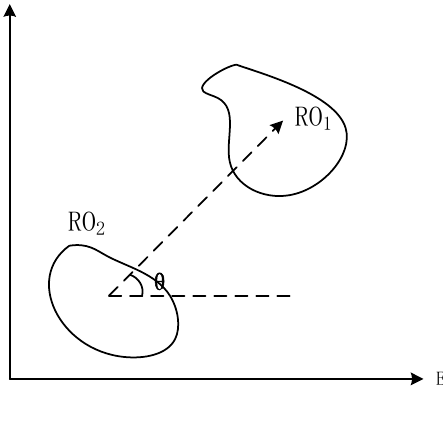
Figure 1. Relative angle of ROs.